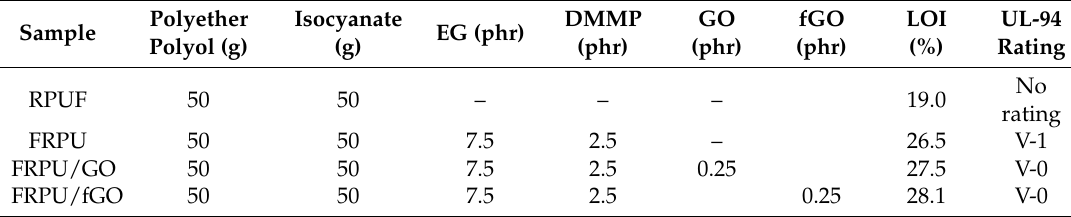
Table 1. Formulations containing different additive levels, limiting oxygen index (LOI) value, and UL-94 rating of the